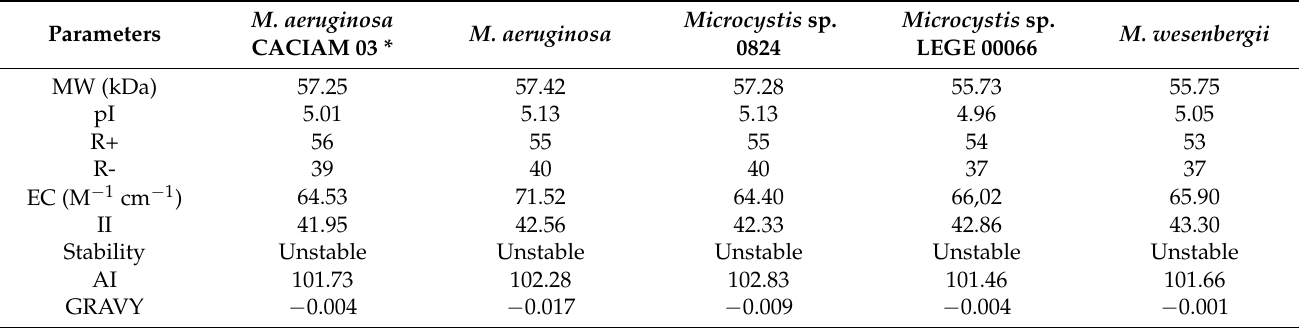
Table 3. Physicochemical parameters of β -glucosidases from Microcystis sp. using Expasy’s Prot- param